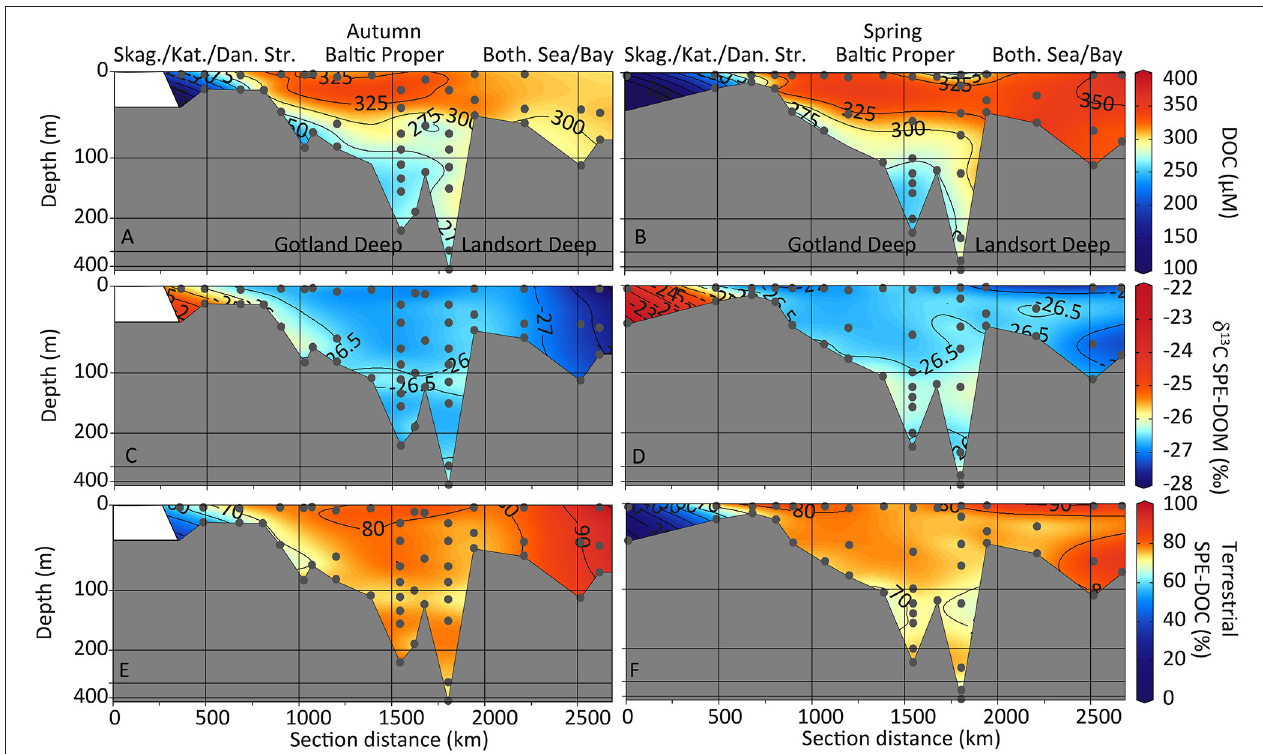
FIGURE 4 | Contour depth plots of the sampling transects. Bulk DOC concentrations (A,B) , 13 C isotopic SPE-DOM composition (C,D) , and the relative abundance of terrestrial SPE-DOC (based on δ 13 C SPE-DOM; E,F ) are shown for autumn (left) and spring (right) sampling. Non-linear depth scale. Skag., Skagerrak; Kat., Kattegat; Dan. Str., Danish Straits; Both. Sea/Bay, Bothnian Sea and Bothnian